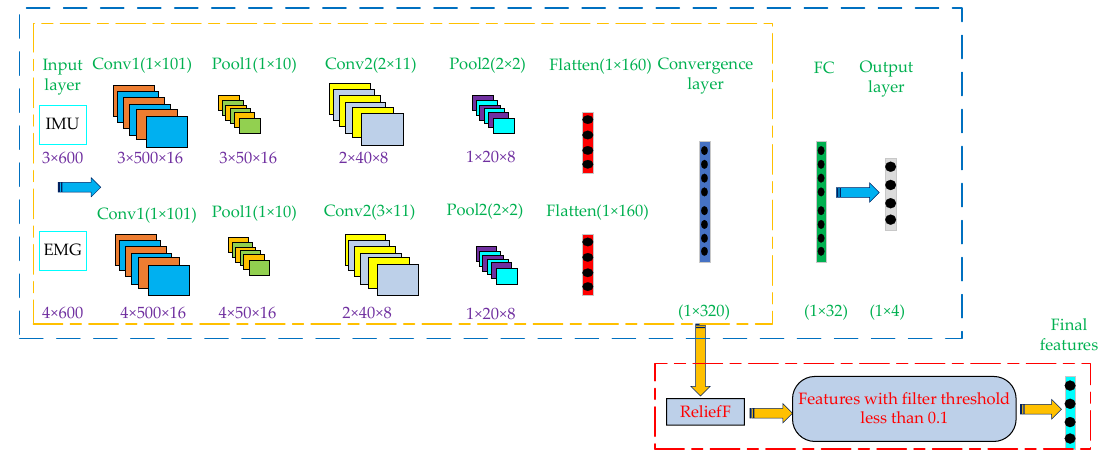
Figure 6. The whole process of feature extraction based on Dual Stream CNN-ReliefF.